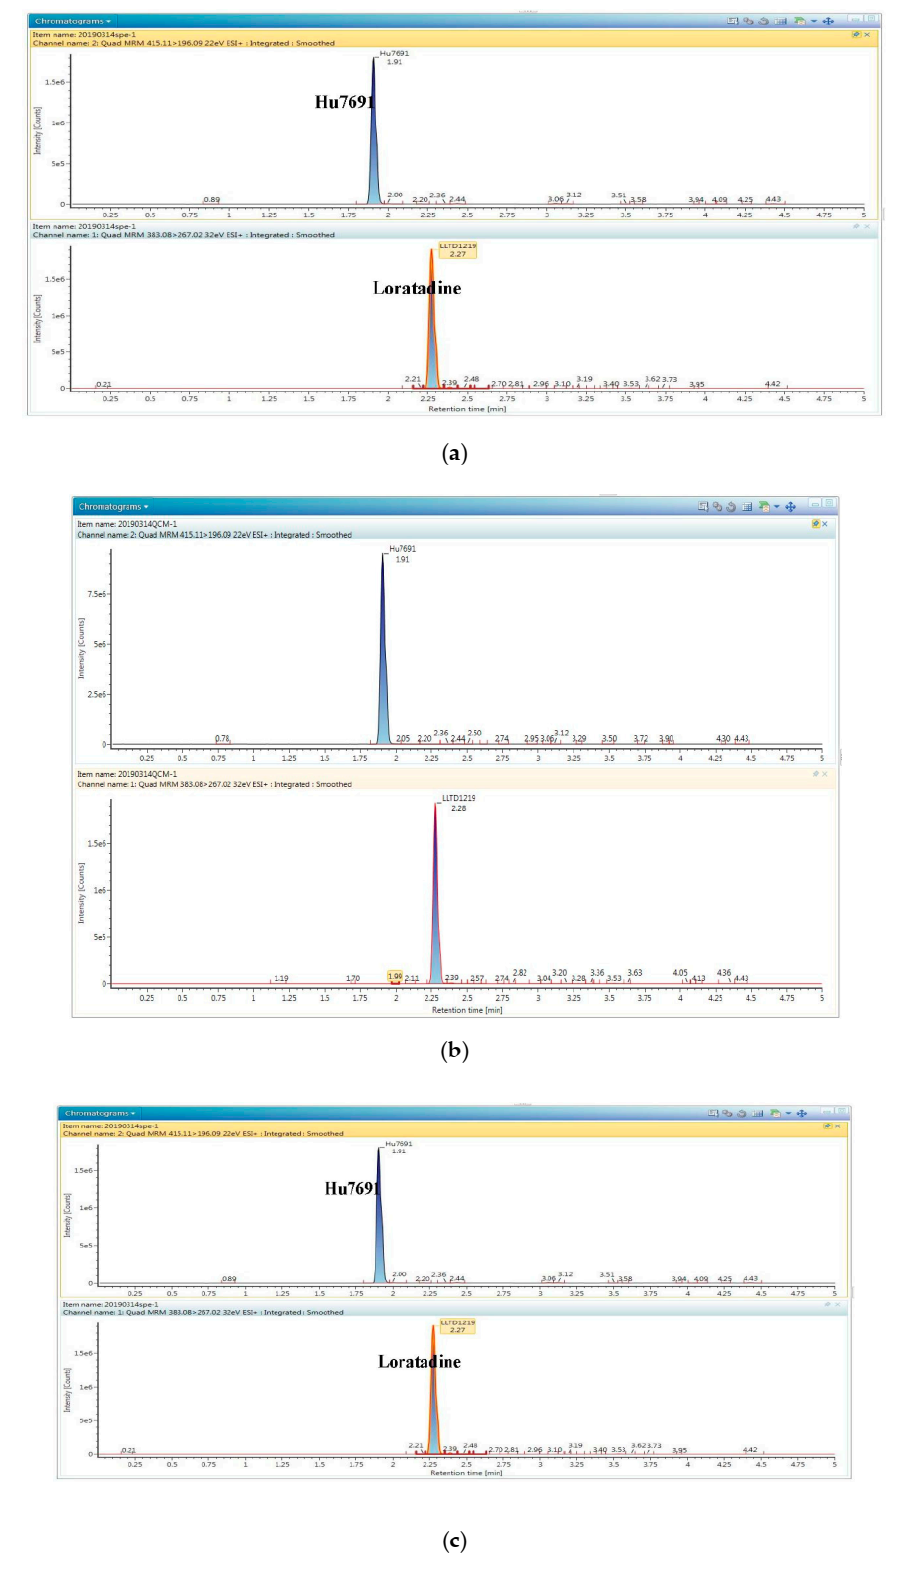
Figure 2. Typical UPLC-MS/MS chromatograms of ( a ) blank plasma; ( b ) blank plasma spiked with Hu7691 at LLOQ; and ( c ) an actual sample acquired from a dog 2 h after gavaging